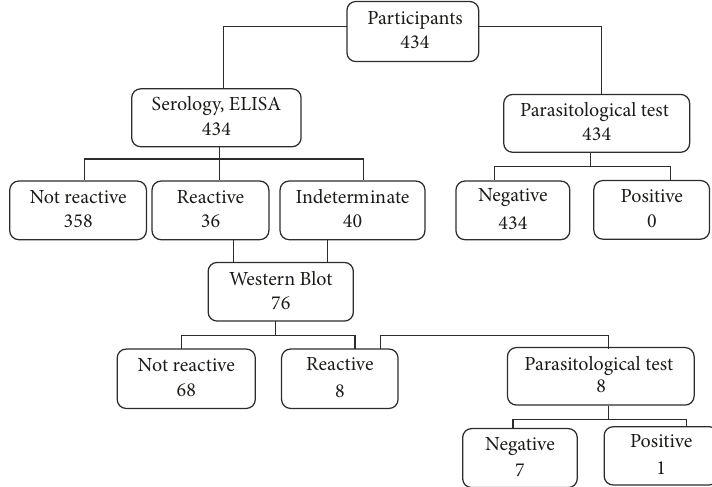
Figure 2: Flowchart of the survey and tests performed in the study population.